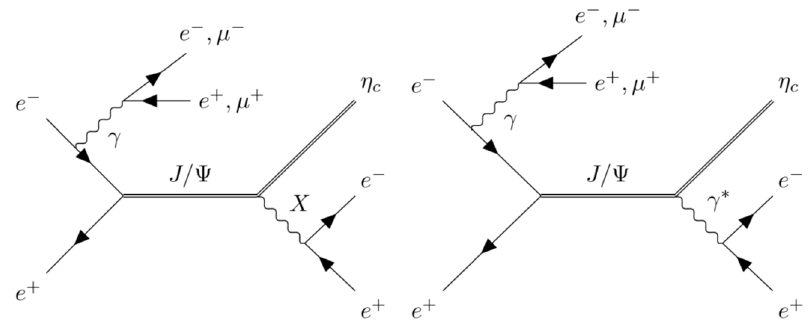
Figure 4 . The Feynman diagrams of the signal (left) and background